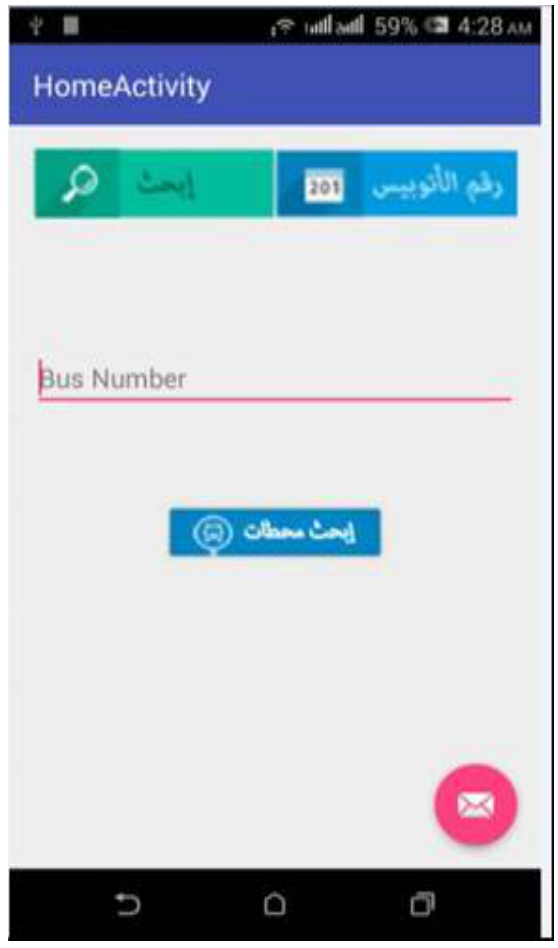
Figure 3. Interface screenshot: Get bus route given a bus